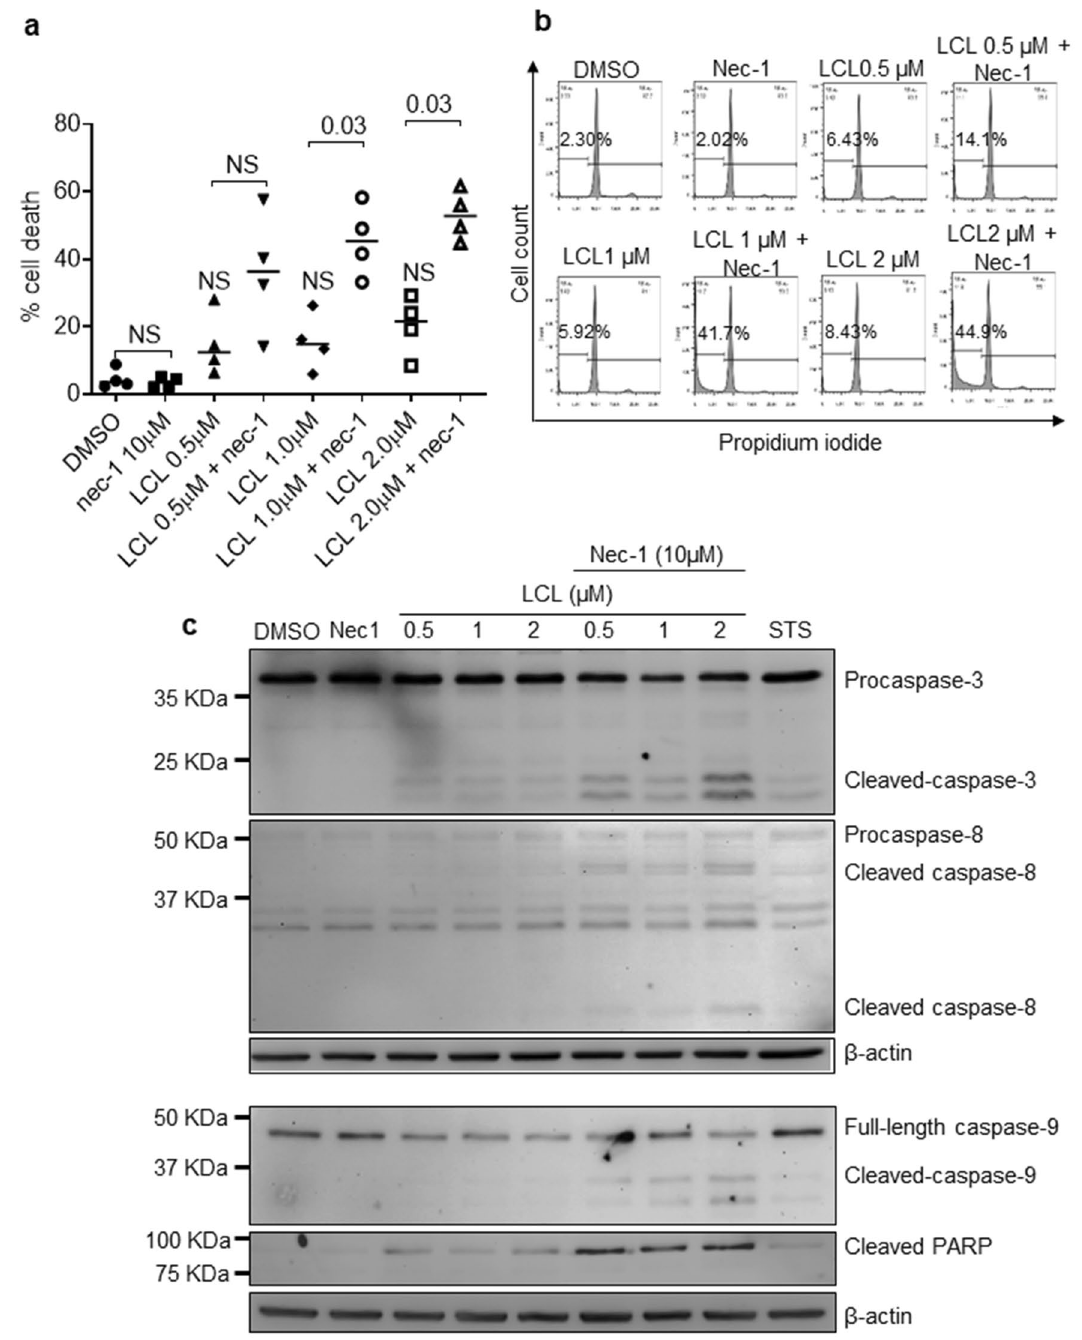
Figure 8. Concomitant downregulation of cIAP1/2 and RIPK1 in MDMs derived from healthy donors results in activation of apoptosis. ( a ) MDMs were treated with 10 μM necrostatin-1 for 2 h followed by the addition of increasing concentration of LCL161 for 48 h or staurosporin (STS). Cell death was assessed by intracellular PI staining and flow cytometry. The p -values were calculated using two tailed Mann–Whitney U test (n = 4). ( b ) The representative histograms of the four experiments are shown. ( c ) MDMs treated as above with necrostatin-1 and LCL161 were harvested and subjected to western immunoblotting for caspase-3, -8, and -9, cleaved PARP, and beta-actin. The blots shown are a representative of three experiments. The uncropped western blot images are in Supplementary Fig. 10. The densitometric readings for figure ( c ) are shown in Supplementary Fig.